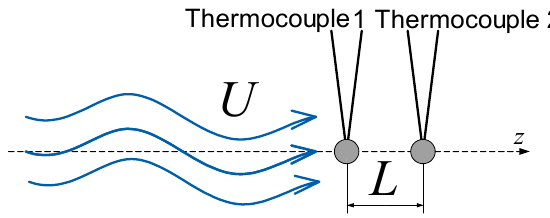
Figure 4. Scheme of the thermocorrelation method for measuring the velocity.